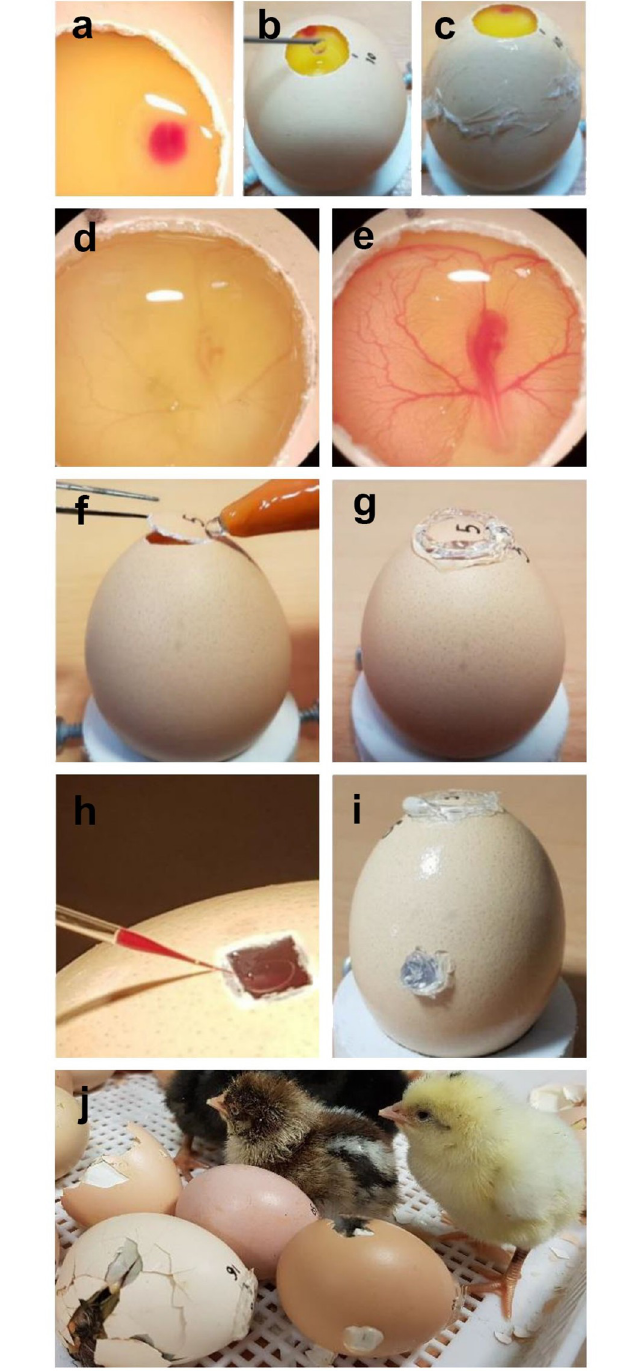
Fig 1. The three-stage injection method in chicken embryos from the blastoderm stage to the hatching using original eggshells. (a) A round window with a diameter of approximately 1.5 cm was opened at the pointed end of the non-incubated fertilized eggs (stage X); the viral solution, containing phenol red, was injected into the sub-germinal cavity. The injected solution had to be spread across the area pellucida but it should not surpass the borders of the area opaca. (b) Thin albumen was added to fill the shells so that they would slightly overflow when the cover was put on the window. (c) Plastic wrap was stretched over the window and its ends were secured with a hot glue gun to the eggshell. (d) After 55 h of incubation, the plastic wrap was removed and the second injection was performed into the dorsal aorta at HH stages 14–15 embryo. (e) The distribution of the injection solution, containing phenol red, throughout the